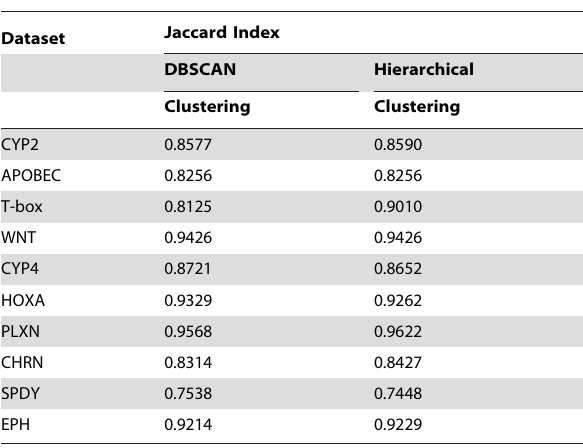
Table 6. The hybrid distance measure (with the same parameters in Table 3) is tested with another clustering algorithm, the hierarchical